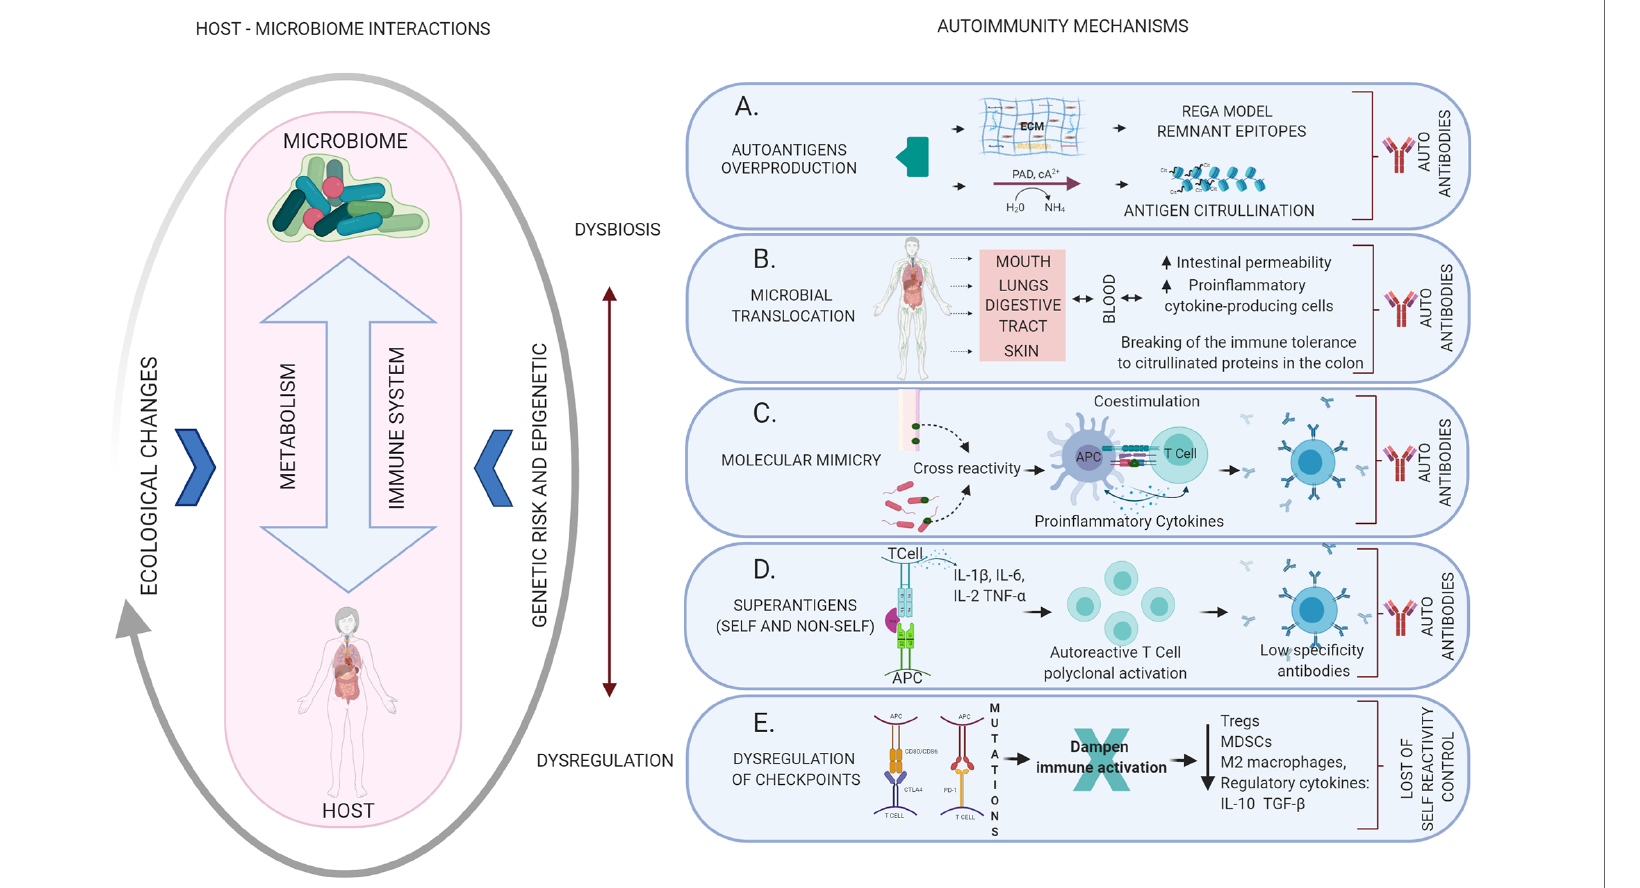
FIGURE 2 | Mechanisms of autoimmunity triggered by dysbiotic changes and dysregulation of the immune system mediated by altered microbiome-host relationships. The host-microbiome interaction may be in fl uenced by several ecological changes (eating habits, aging, infection, among others) that may generate dysbiosis with the consequent activation of different local or systemic autoimmune mechanisms. (A) Autoantigens overproduction: the result of the breakdown of the extracellular matrix creating “ remnant epitopes ” that act as autoantigens or because of enzymatic modi fi cation of antigens (citrullination). (B) Microbial translocation: bacteria, their products or even products of immune activation against them, can migrate through the bloodstream to different organs leading to an alteration of the local in fl ammatory response and the production of autoantibodies. (C) Molecular mimicry: cross immune response against self-antigens induced by microbial epitopes similar in composition or structure. (D) Superantigens: Self or non-self-superantigens interact with the V b variable region of the TCR activating and causing T cell expansion. This is a low speci fi city recognition, which generates low-af fi nity antibodies that easily end up activating autoimmune mechanisms. (E) Dysregulation of checkpoints: alteration of the CTLA4 and PD-1 autoreactivity checkpoints in T cells, resulting in the loss of physiological modulation or regulation of the autoimmune